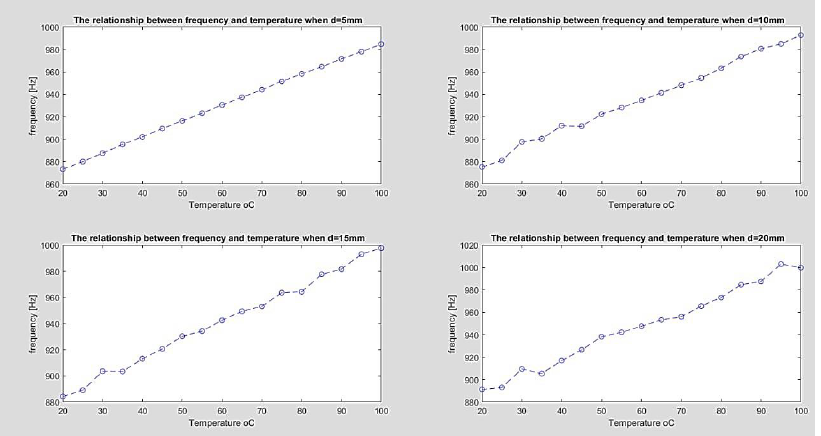
Figure 9. The relationship between frequency variation and temperature change for different di- ameters.